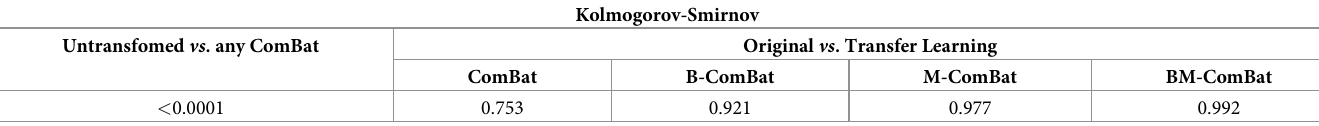
Table 2. P-values of Kolmogorov-Smirnov comparing different 4 ComBat versions using Original and TL data.